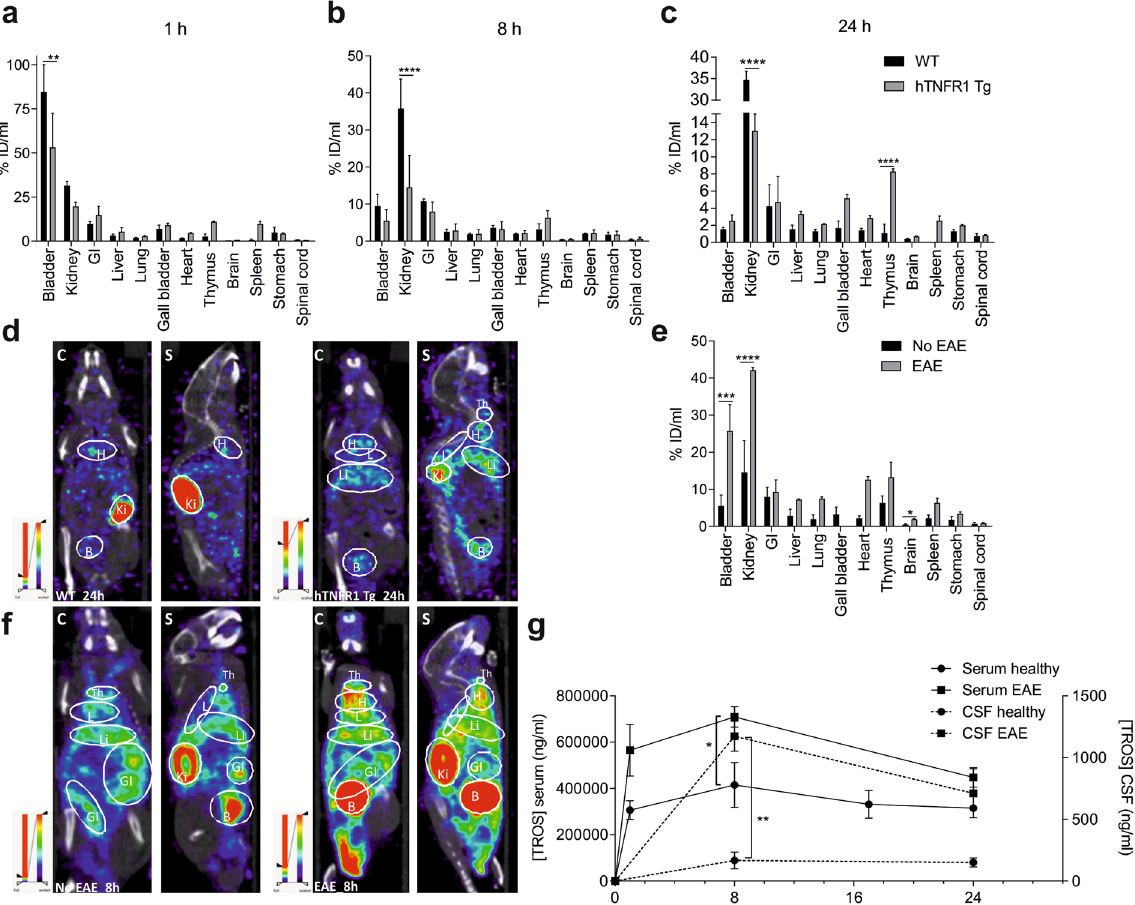
Figure 1. ( a – g ) Whole-body biodistribution analysis of 99m Tc-TROS and kinetics of TROS in serum and CSF of healthy and EAE mice. TROS was radio-labeled with 99m Technetium ( 99m Tc) and (a – d ) 200 µ g (72 MBq) 99m Tc-TROS was injected intraperitoneally (i.p.) in healthy wild type (WT) and hTNFR1 transgenic (Tg) mice. SPECT/CT acquisition was performed 1 h, 8 h and 24 h post-injection (n = 3/group/time point). ( a–c ) Biodistribution was assessed by measurement of activities in tissues based on the SPECT images at the different time points by AMIDE. ( d ) Representative coronal (C) and sagittal (S) views of fused SPECT/CT images of healthy WT (left) and hTNFR1 Tg (right) mice 24 h post-injection. (f,e ) hTNFR1 Tg mice were immunized with MOG 35-55 and pertussis toxin to induce EAE and 16 days post-immunization (PI, peak of the disease) 500 µ g (94.3 MBq) 99m Tc-TROS was injected i.p. in EAE and healthy hTNFR1 Tg mice (no EAE, n = 3/group). 8 h post-injection, SPECT/CT imaging was performed and representative coronal (C) and sagittal (S) pictures were taken of fused SPECT/CT images of healthy, no EAE mice ( f , left) and EAE mice ( f , right). ( e ) Biodistribution was assessed by measurement of activities in tissues based on the SPECT images 8 h post injection by AMIDE. ( g ) 500 µ g TROS was injected i.p. in healthy (no EAE) and EAE hTNFR1 Tg mice 16 days PI. The concentration of TROS was determined in serum and cerebrospinal fluid (CSF) at the indicated time points. TROS levels were determined (n = 4 ‒ 7 serum/time point; n = 3 ‒ 4 CSF/time point). Data information: Bars (%ID/ml) and graphs represent mean ± SEM. Bio-distribution data were analyzed in all organs between the two groups with a two-way ANOVA and TROS kinetics in serum and CSF were compared at the indicated time points with an unpaired t-test. * 0.01 ≤ p < 0.05; ** 0.001 ≤ p < 0.01; *** 0.001 ≤ p 0.0001, **** p < 0.0001. Non-statistically significant differences are not indicated on the